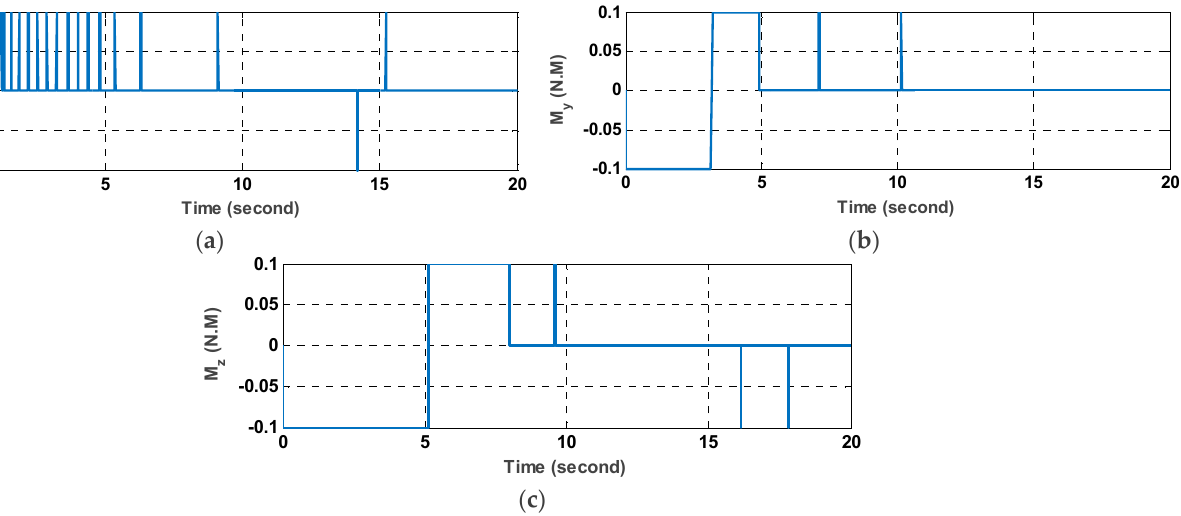
Figure 12. The control moment of the thruster in the ( a ) X, ( b ) Y, and ( c ) Z axis.